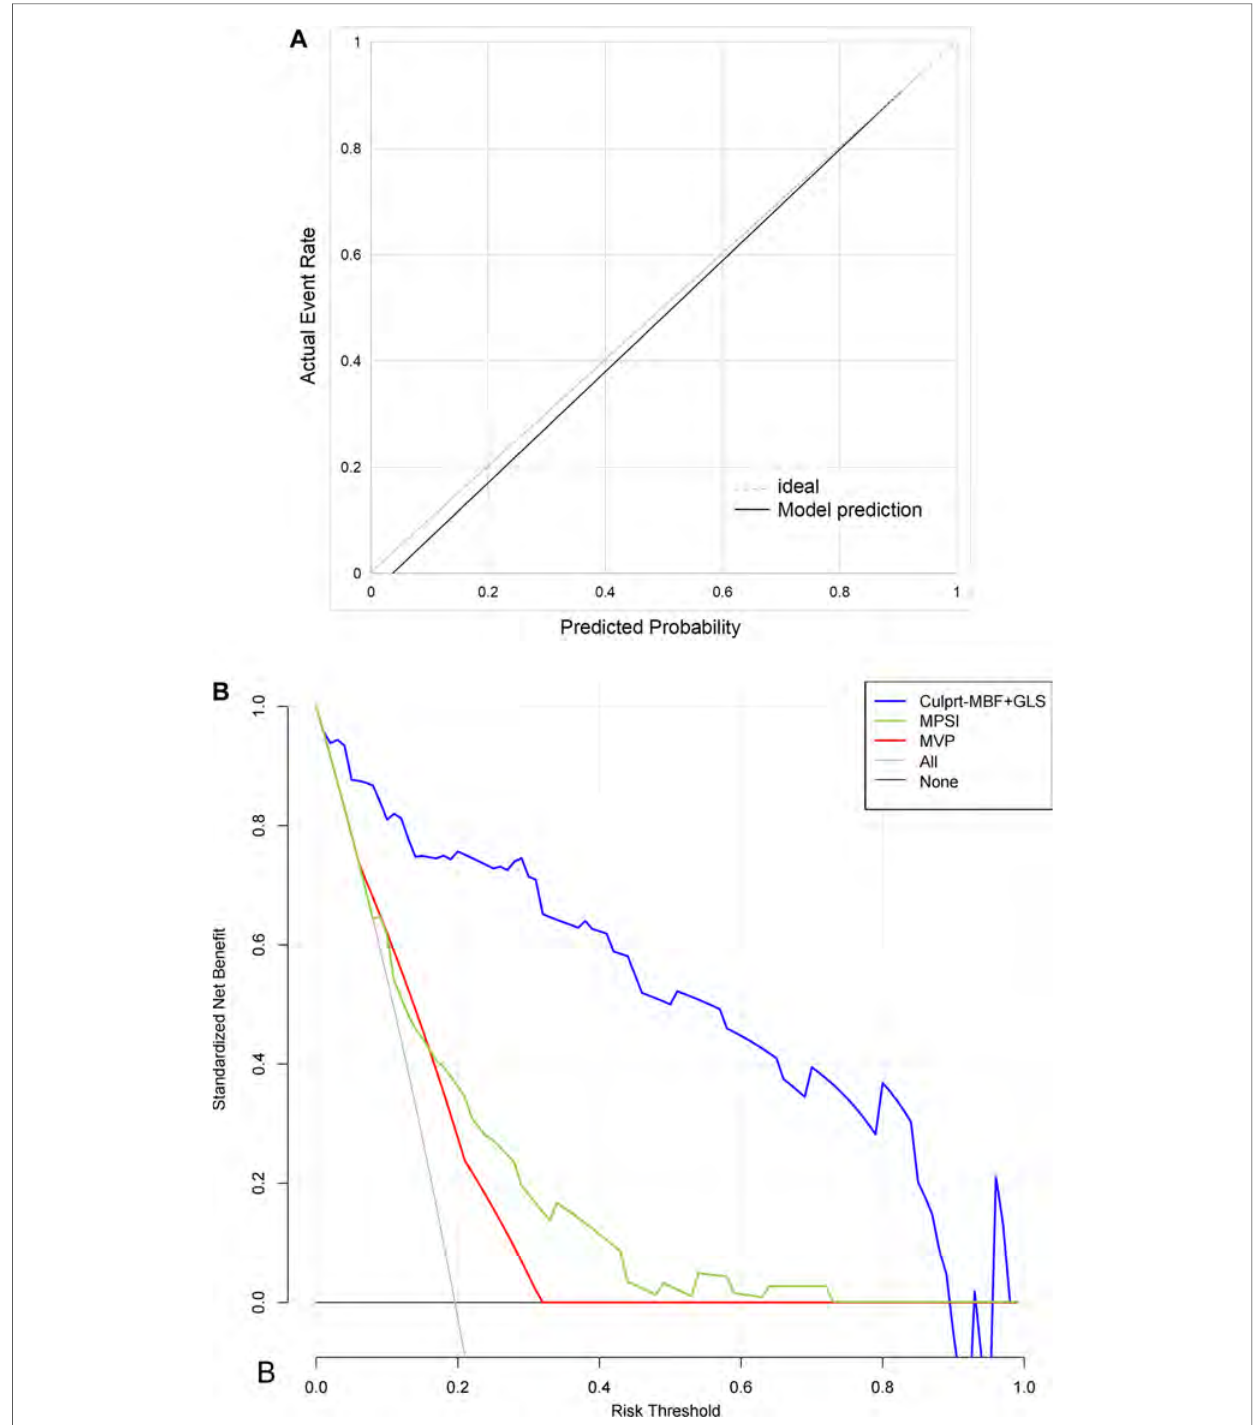
FIGURE 4 The calibration curves and decision curve. ( A ) The calibration curves. Perfect prediction would correspond to the 45° dashed line. The black line represents the observed model performance. ( B ) The decision curve. “ None ” model means that all patients are considered as not having MACE. “ All ” model means that all patients are considered as having MACE. The preferred model is considered to have the highest standardized net bene fi t for a given threshold